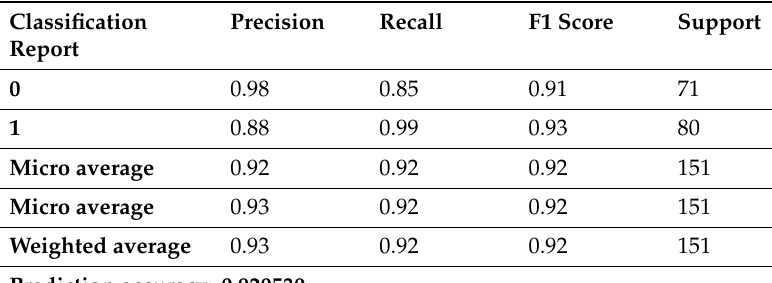
Table 4. Performance of the developed CNN